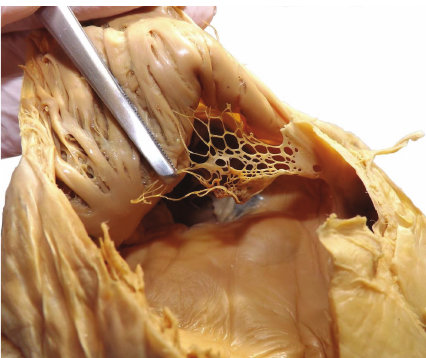
Figure 3: Fixed Chiari network in proximity to the inferior vena cava after removal of the